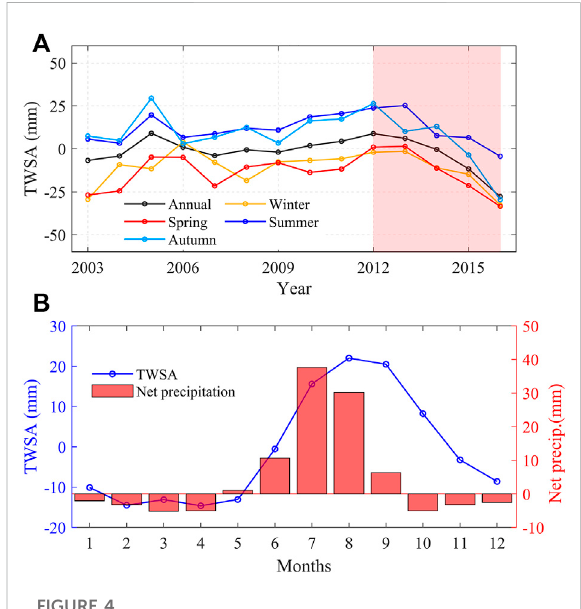
FIGURE 4 The TWSA in the Tibetan Plateau from 2003 to 2016. (A) is annual and seasonal TWSA, and (B) is monthly TWSA and net precipitation (precipitation minus actual evapotranspiration). The anomalies base period of TWSA and net precipitation is between January 2004 and December 2009.